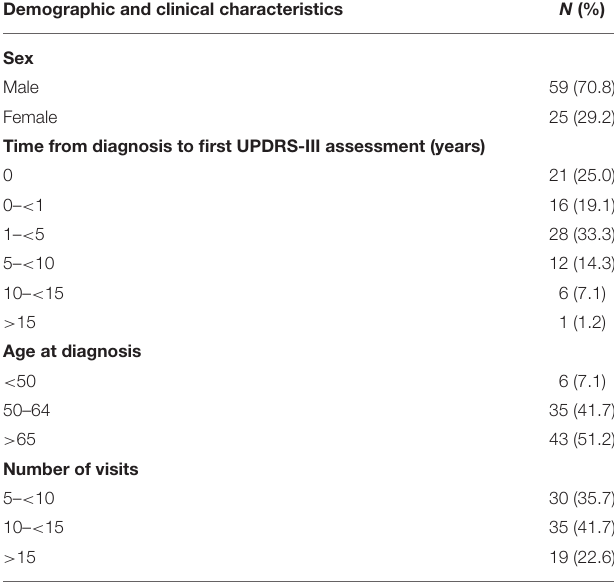
TABLE 1 | Demographic and clinical characteristics of the Parkinson’s patients analyzed. Demographic and clinical